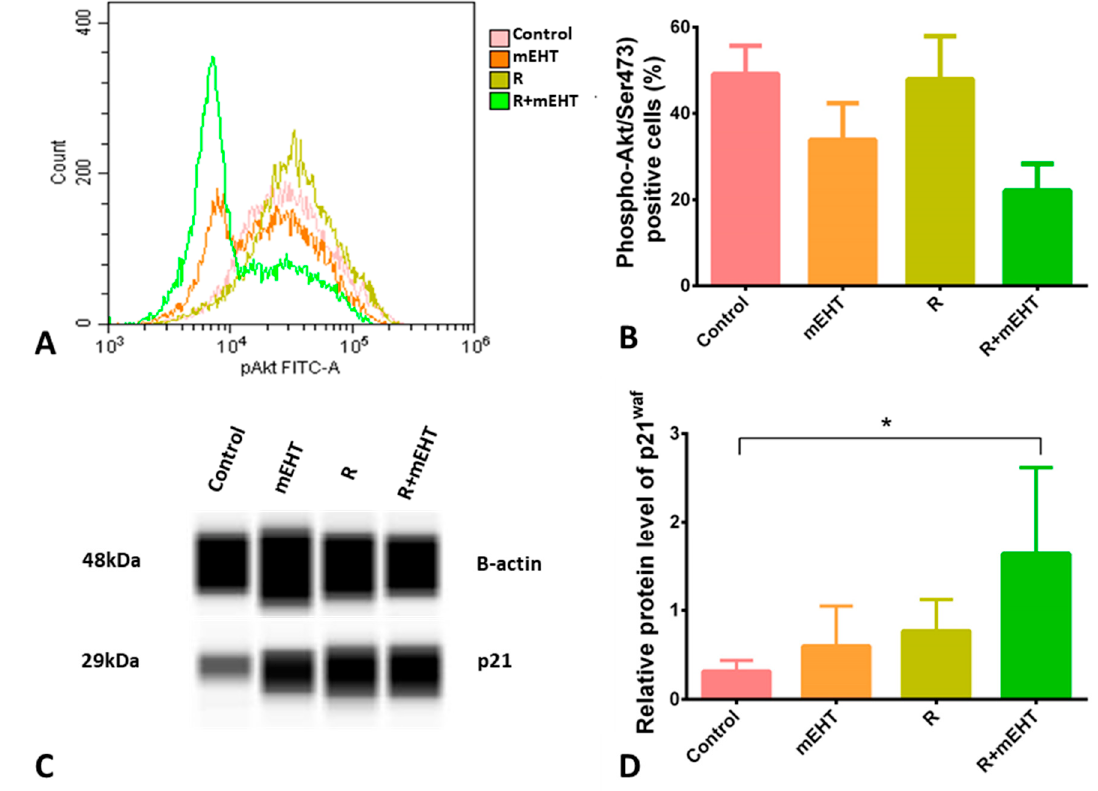
Figure 4. Treatment induced reduced p-Akt / Ser473 and elevated p21 waf1 levels in Panc1 cultures 24 h post-treatment. Flow cytometry histogram ( A ) and quantitation graph of p-Akt / Ser473 levels. Kruskal–Wallis test revealed a significant di ff erence ( p = 0.015) among the 4 groups ( B ). p21 waf1 protein expression detected in Western blots ( C ). Kruskal–Wallis test ( p = 0.049) revealed a significant di ff erence among groups. Dunn’s post-hoc test confirmed a significant increase in p21 waf1 level in the R + mEHT group compared to the control ( p = 0.045) ( D ). The asterisk (*) marks the value of p ≤ 0.05.